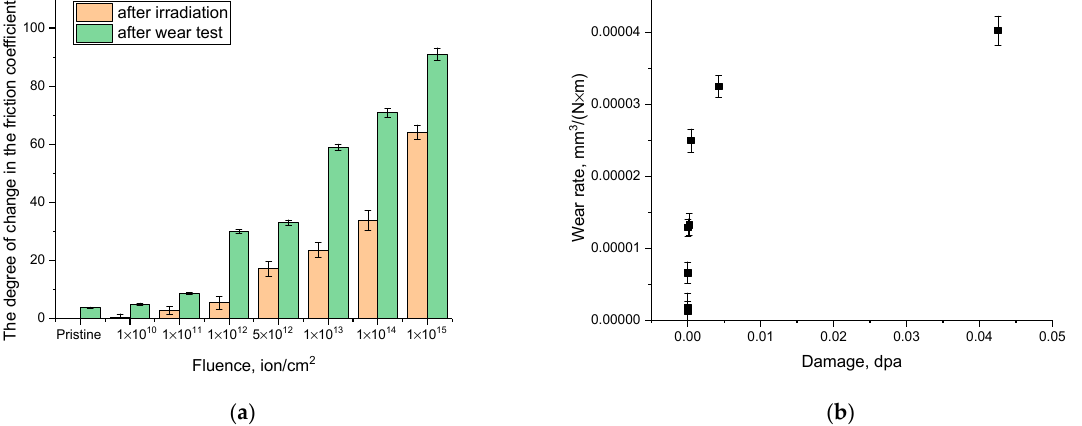
Figure 11. ( a ) Diagram of the change in the dry friction coe ffi cient after irradiation in comparison with the initial value of the coe ffi cient of friction for non-irradiated samples and after cyclic tests; ( b ) results of evaluation of changes in the wear rate with the accumulation of atomic displacements.